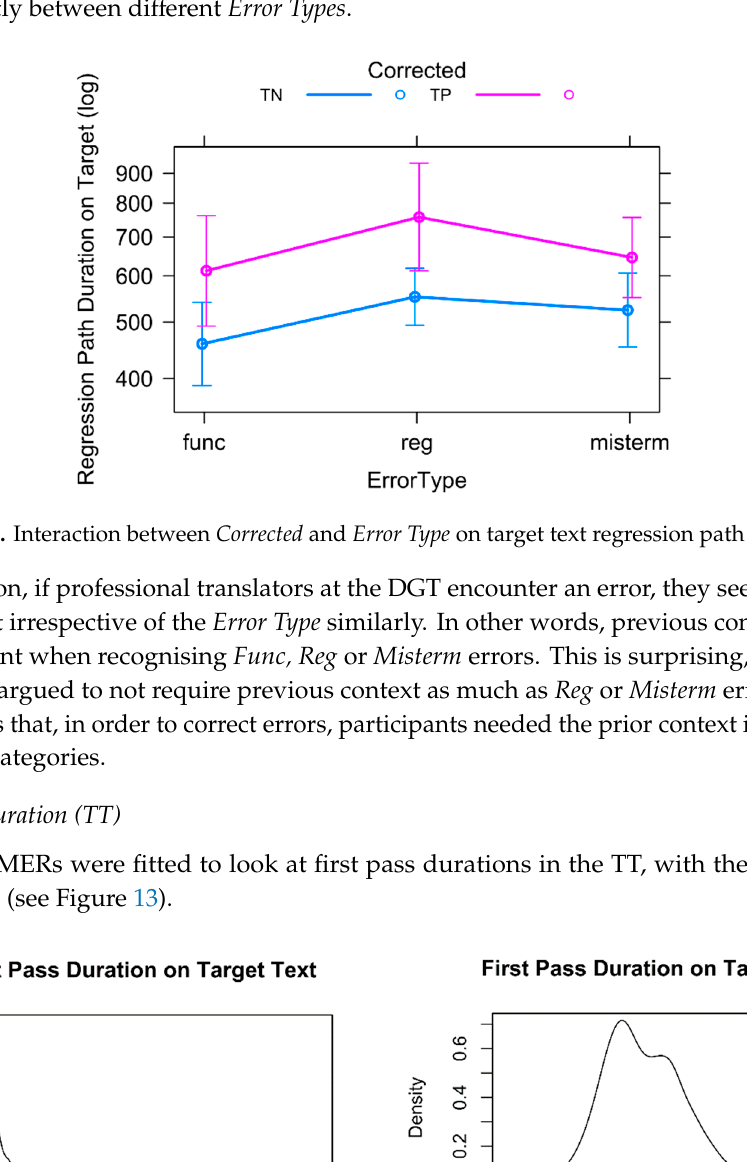
Figure 13. Density plot ( left ) and log-transformed density plot ( right ) for source text first pass duration.